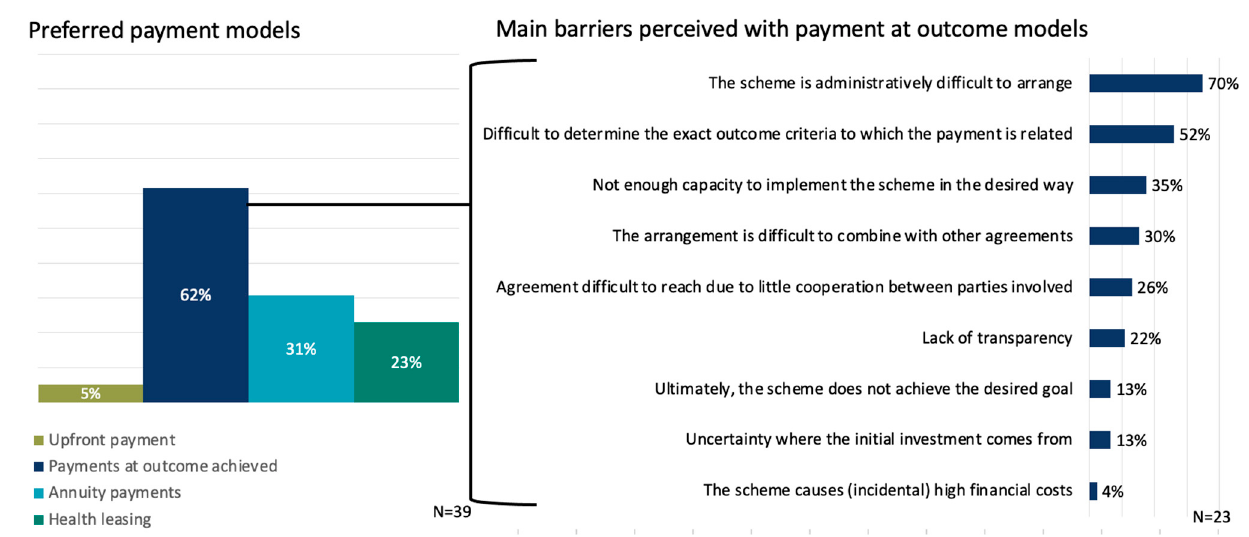
Figure 4. Preferred payment models ( left ) and the main perceived barriers with payment at out- comes achieved models as the most preferred model( right ).